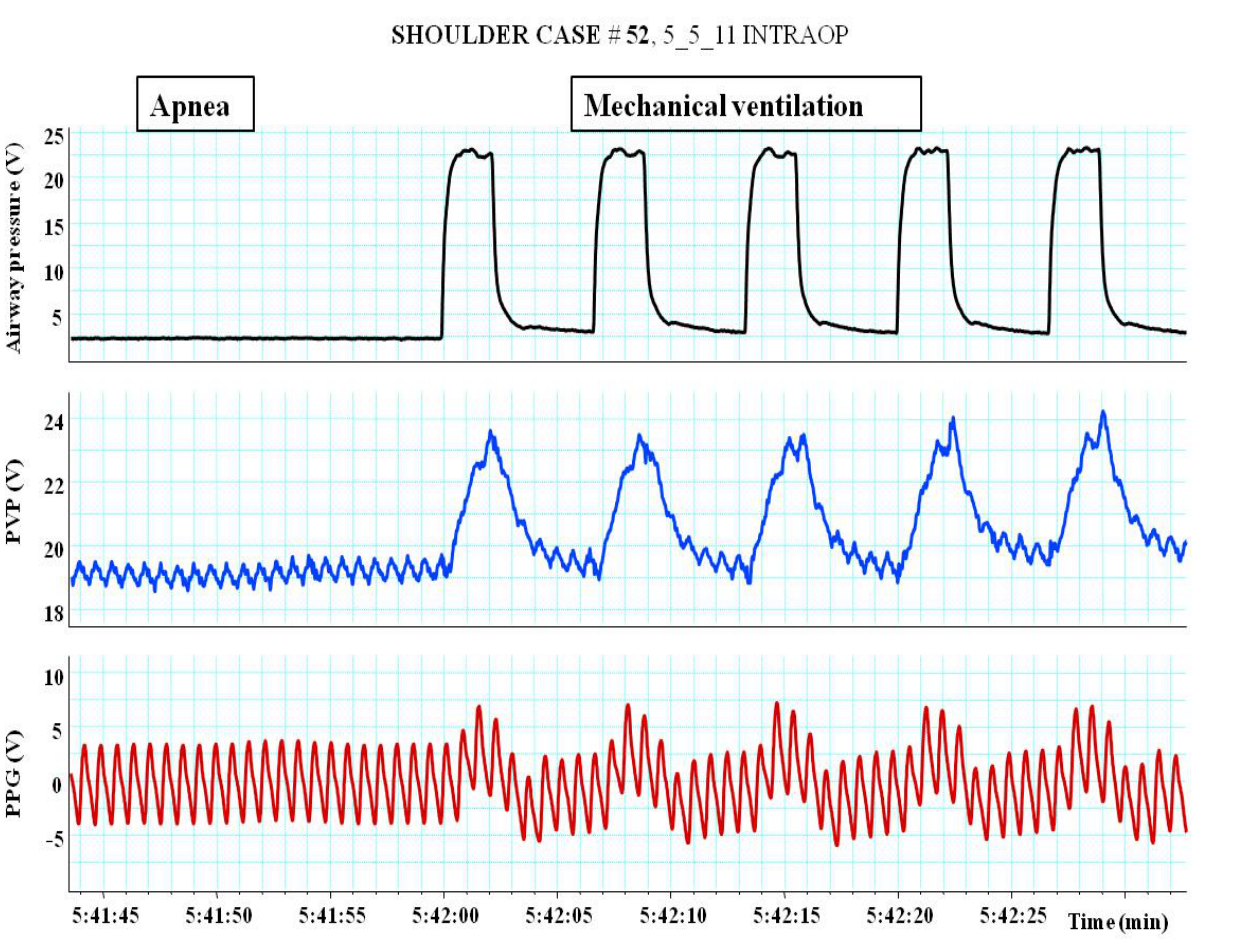
Figure 8. An example of the impact of pressure controlled ventilation (PCV) and apnea on peripheral venous pressure (PVP) and plethysmographic (PPG) waveforms. Each positive pressure ventilation was associated with an increased in peripheral venous pressure (PVP) and PPG amplitude as a result of right ventricle preload and left ventricular afterload reduction